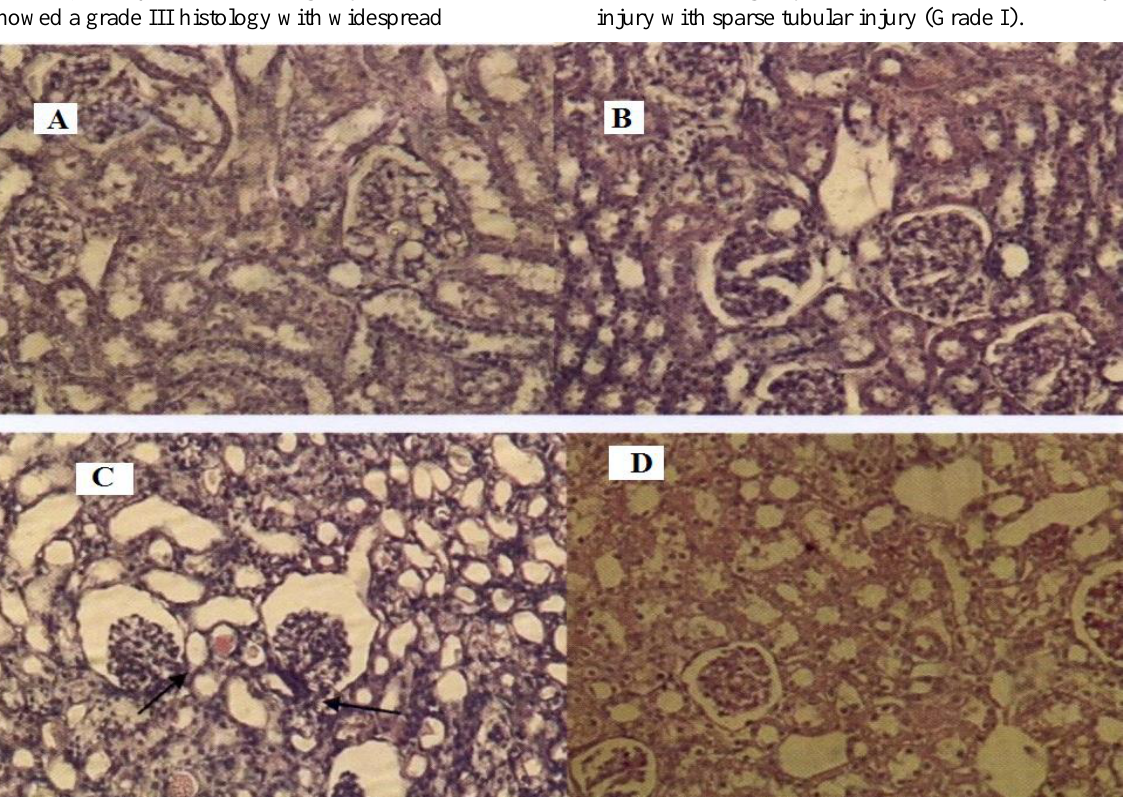
Figure 2. The histopathology of renal cortex from different groups of rabbits (A) negative control, (B) Leek (500 mg/kg/ day) orally for 15 days, (C) cisplatin (3.5 mg/kg) injected i.p., (D) Leek +cisplatin. Observe the normal renal glomeruli and normal tubules in both (A) and (B), shrinkage and atrophy of some renal glomerular with disappearance of Bowman’s space and intensive tubular necrosis in (c) and improvement in the kidney tissues was showed in (d)The slides were stained with hematoxylin and eosin. (×40